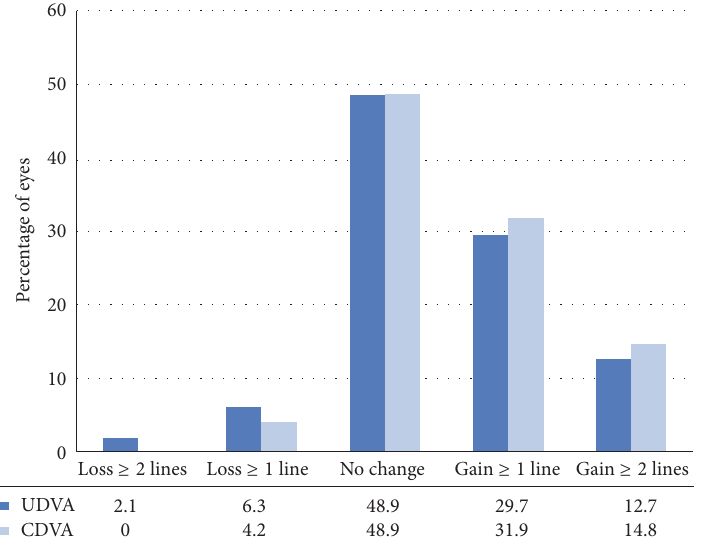
Figure 1: Uncorrected (UDVA) and corrected (CDVA) distance visual acuity changes before and 24 months after accelerated corneal cross- linking.